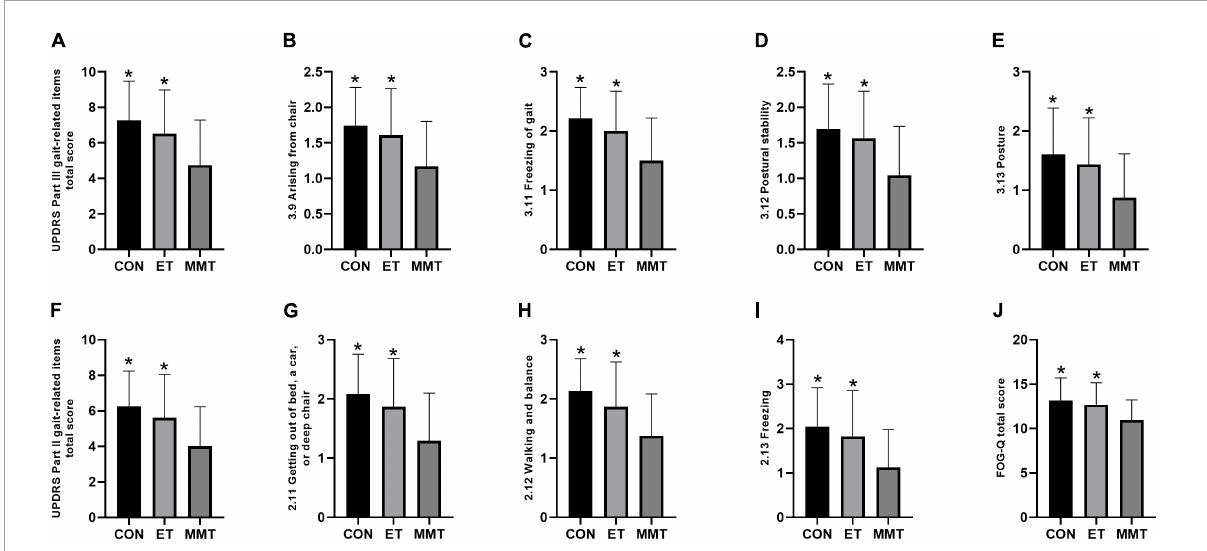
FIGURE3 Change in FOG-Q and the comprehensive motor function. Secondary indicators were expressed in mean ± standard deviation. One-way ANOVA was used to compare the difference between CON, MMT, and ET. Significance level was set at 0.05. * p < 0.05, compared with the MMT group. MMT, music-based movement therapy; ET, exercise therapy; CON, control. UPDRS, Movement Disorder Society-Unified Parkinson’s Disease Rating Scale; FOG-Q, freezing of gait questionnaire. (A–I) Motor function; (J)